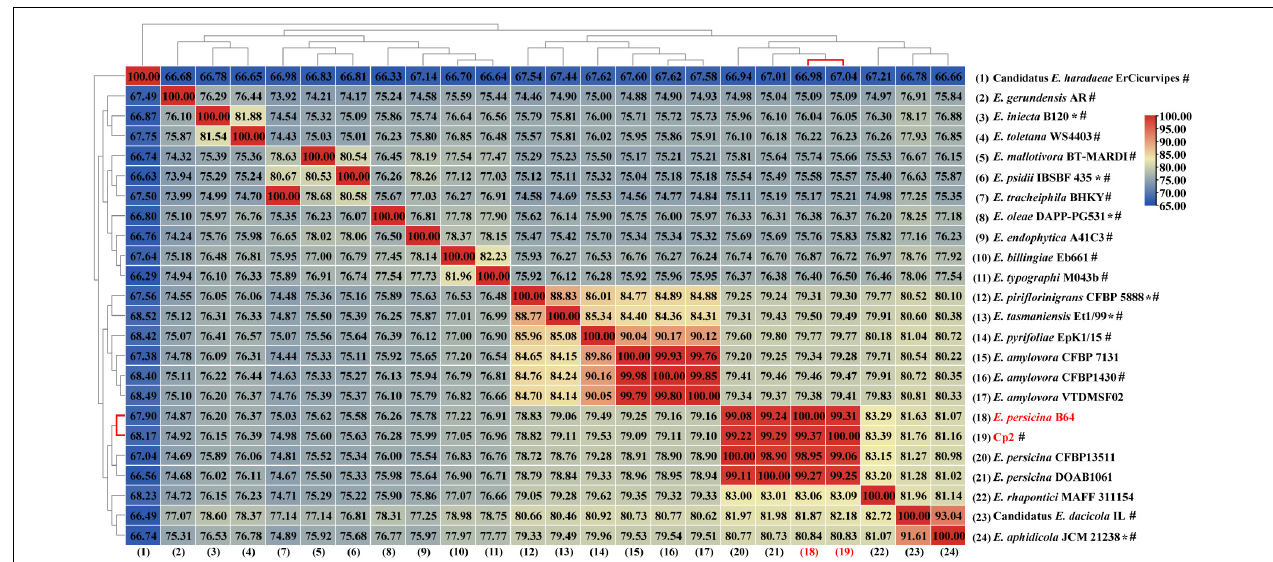
FIGURE 2 | A heat map of average nucleotide identify (ANI) based on the whole genome sequence of strain Cp2 and 23 strains within genus Erwinia. *Represents type strain, # represents reference genome in the NCBI genome database.